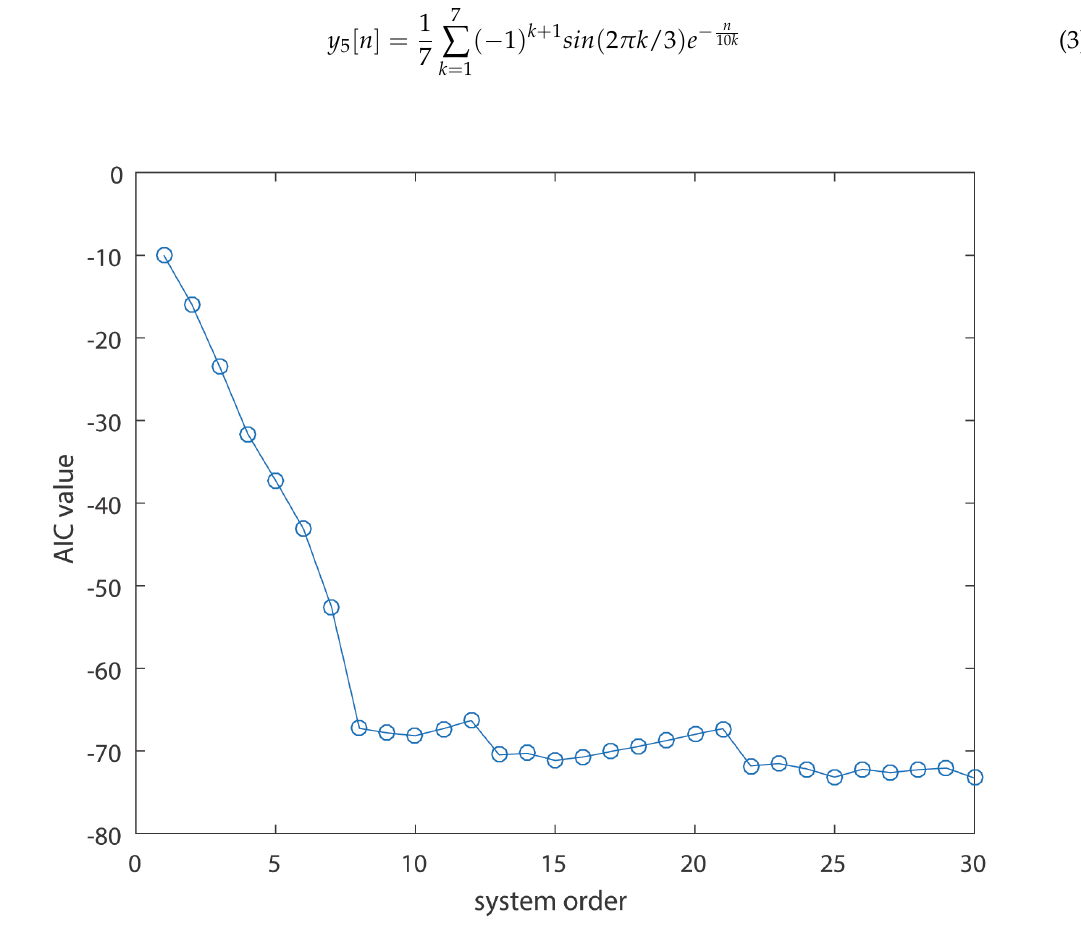
Figure 2. Akaike information criterion (AIC) values as a function of the system order (for system of Equation (3)). Table 1. Co-variance Matrix